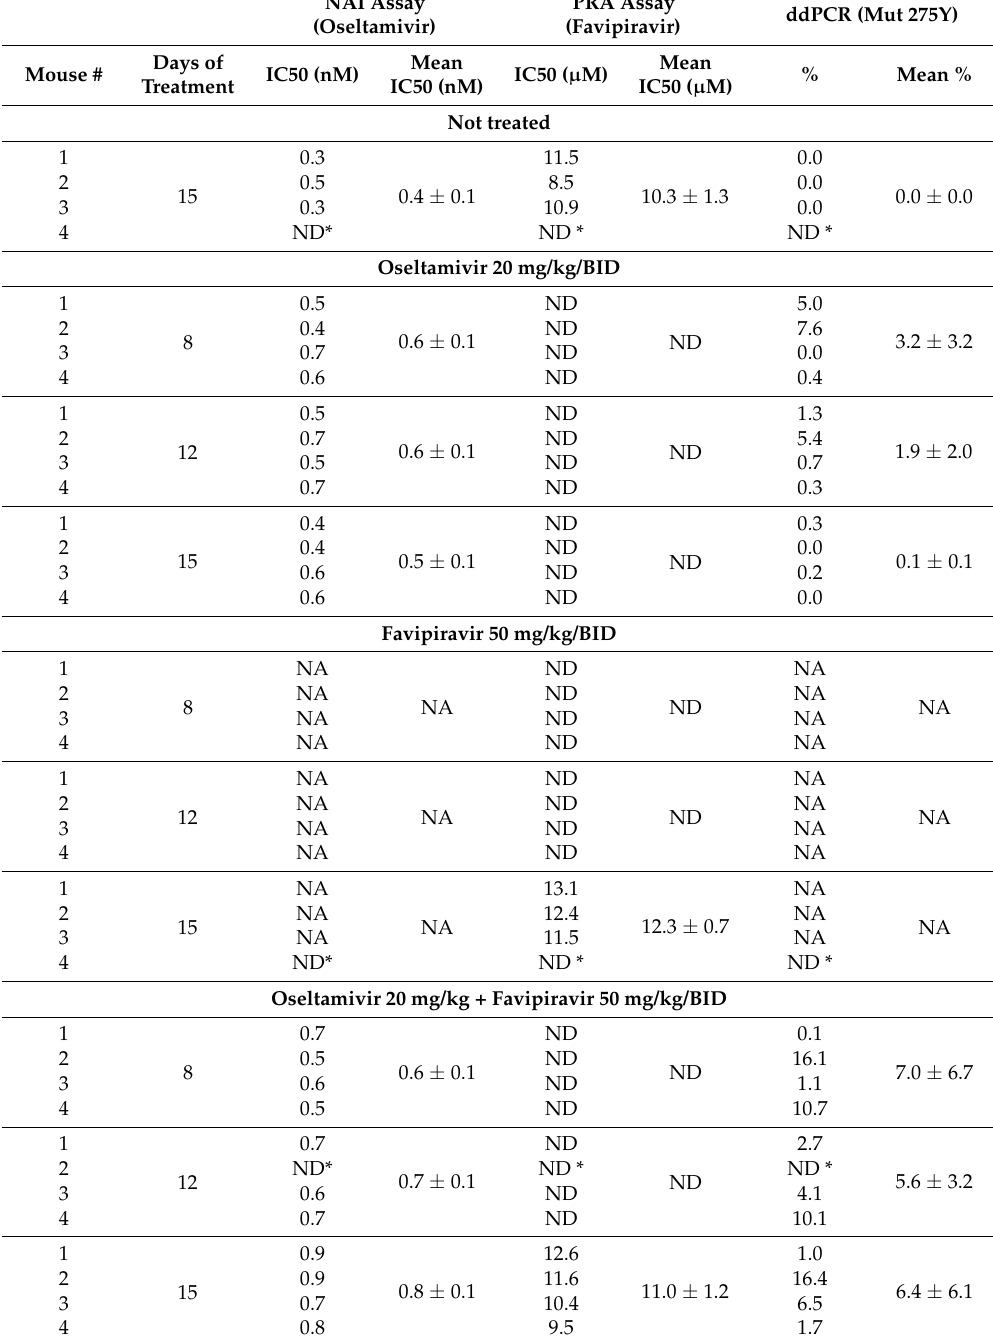
Table 2. Oseltamivir and favipiravir susceptibilities of viruses recovered from individual lungs of IS mice infected with the pH1N1 influenza virus and treated with oseltamivir (20 mg/kg), favipiravir (50 mg/kg) or the combination for 10